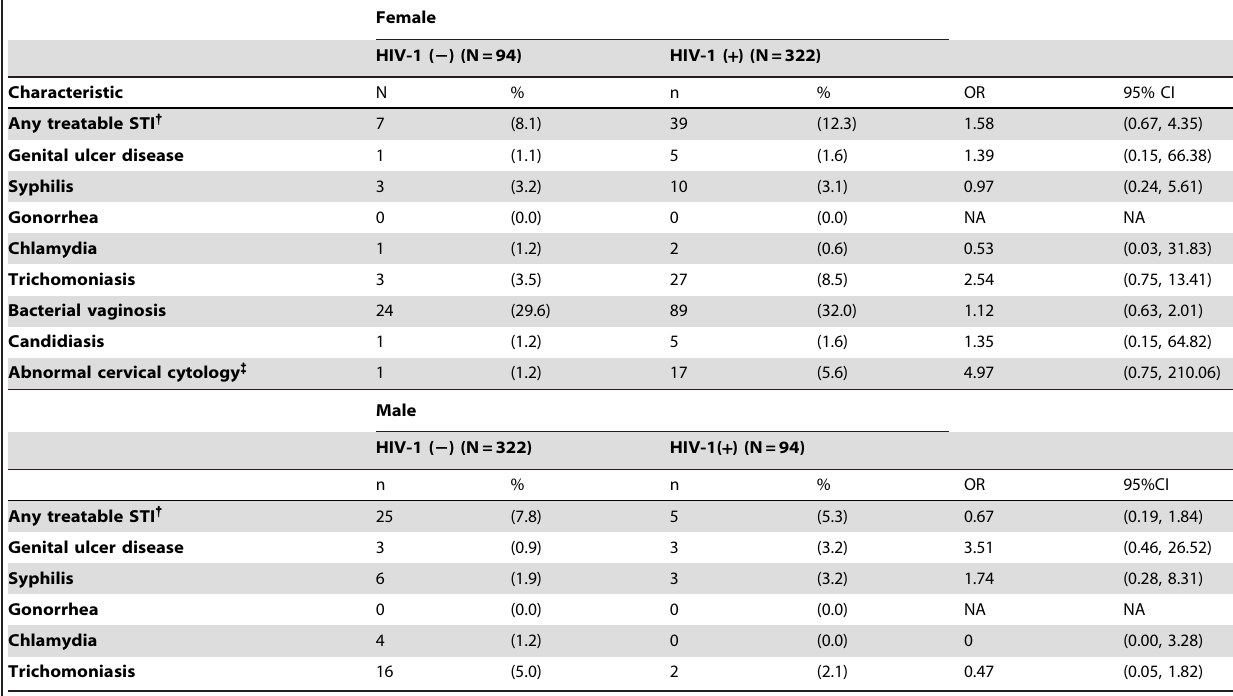
Table 2. Prevalence of genital infections.*